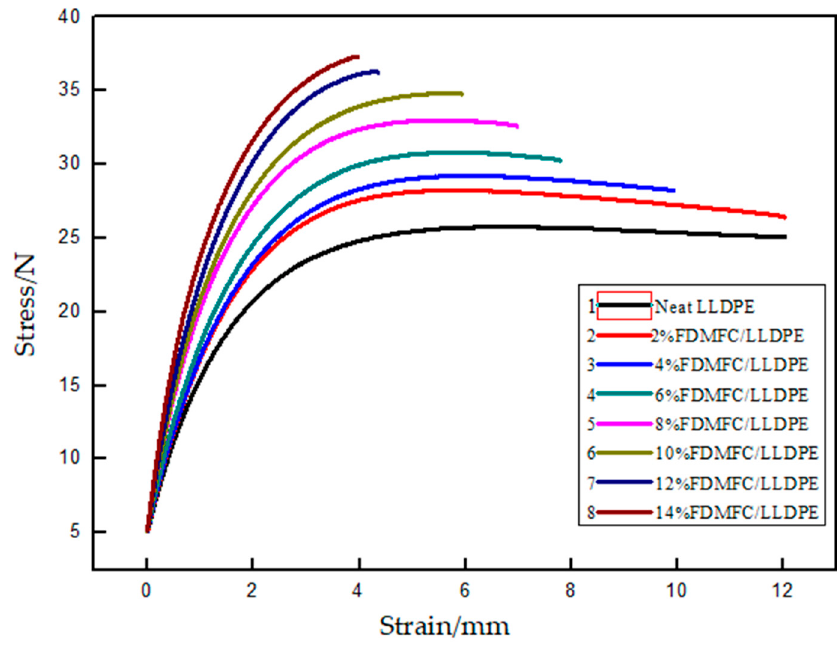
Figure 7. Stress–strain curves of STMFC/LLDPE composites with different MFC contents.